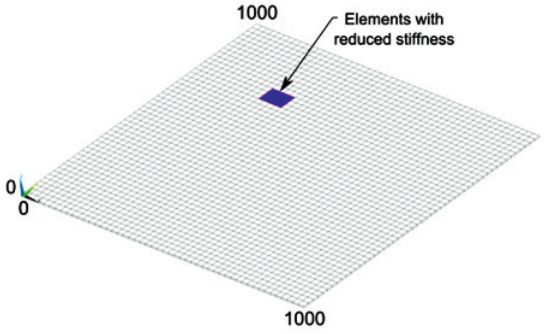
fig. 1. Finite element model for a square plate with an area of reduced stiffness